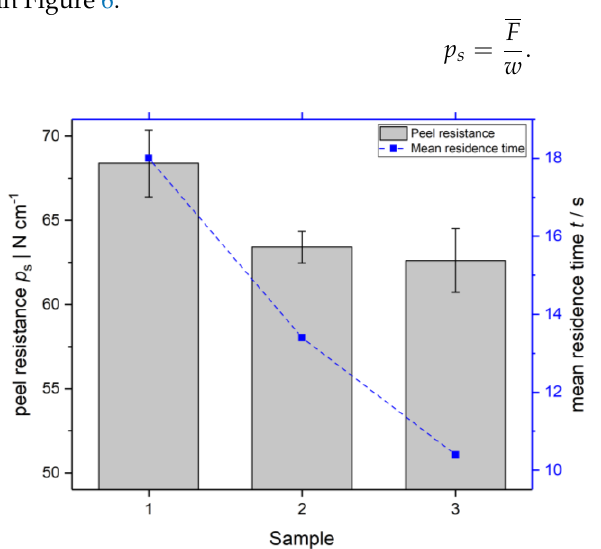
Figure 6. Measured peel resistance of samples 1, 2 and 3 ( 𝑁 = 4 ) and the respective mean residence time in the die.